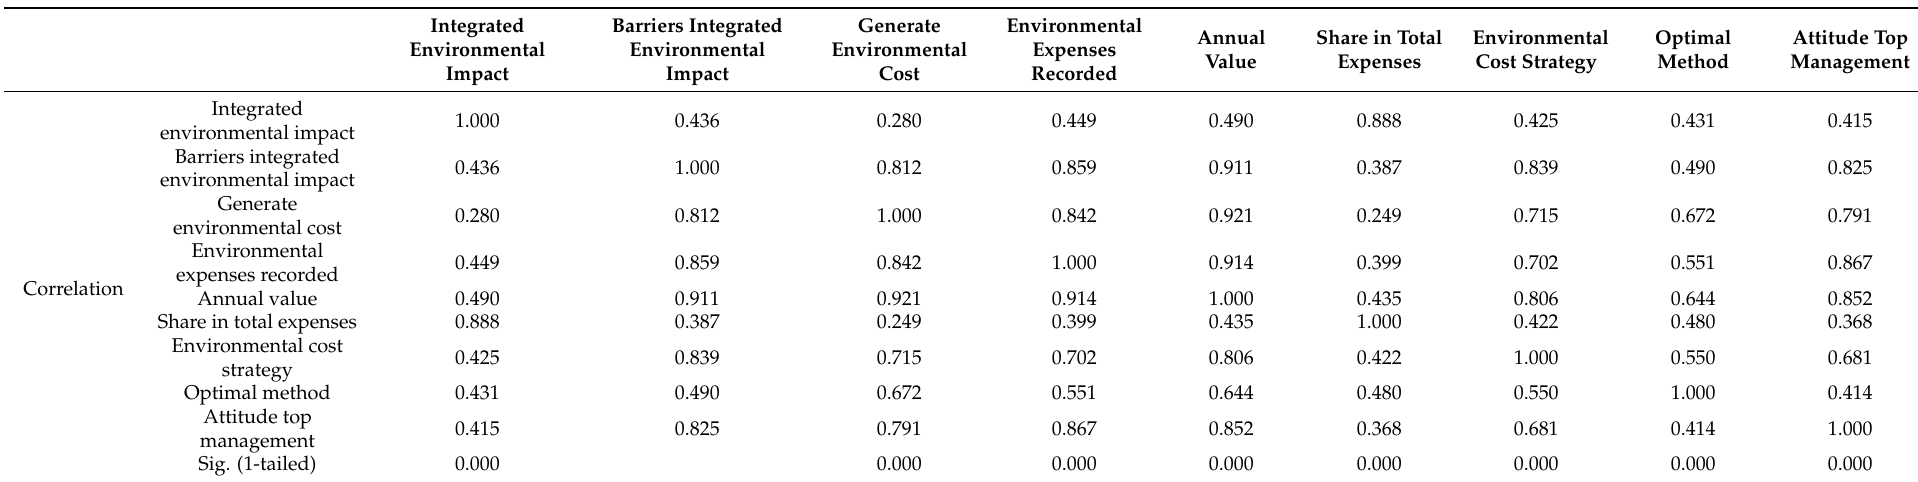
Table 15. Correlation